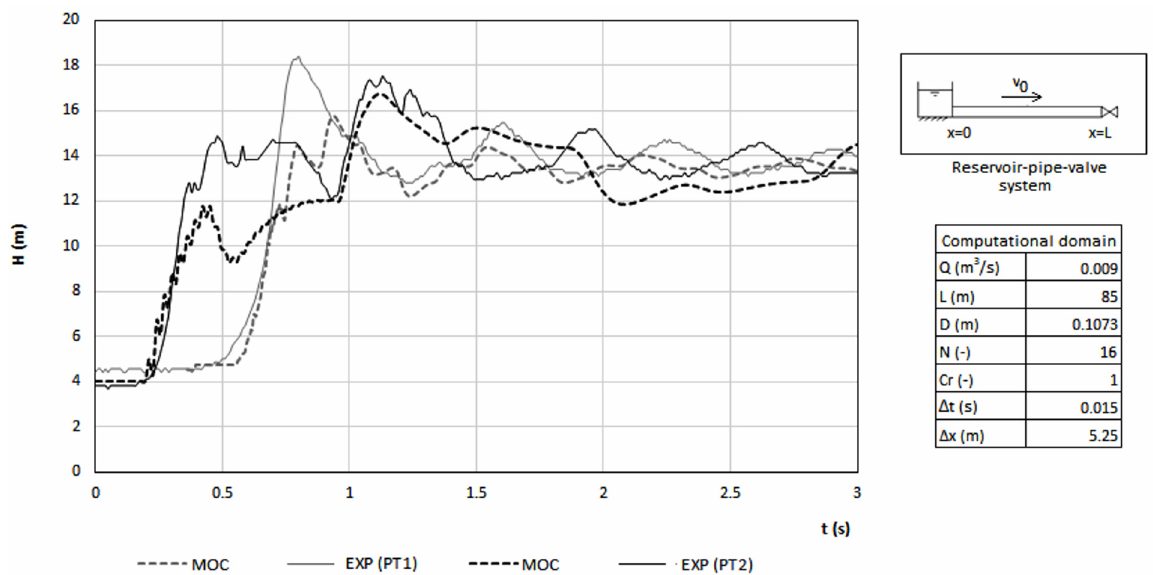
Figure 6. Comparison between method of characteristic (MOC) model results and experimental